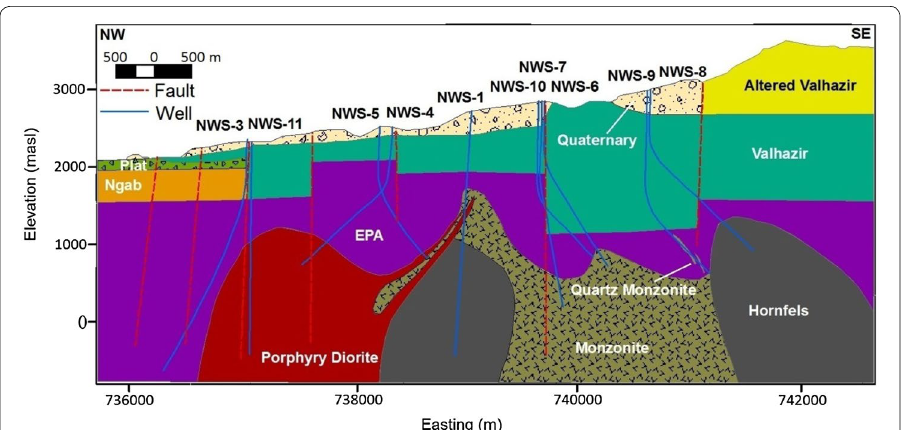
Fig. 3 NW‑SE geological cross section of the NW Sabalan site with the exploration wells and